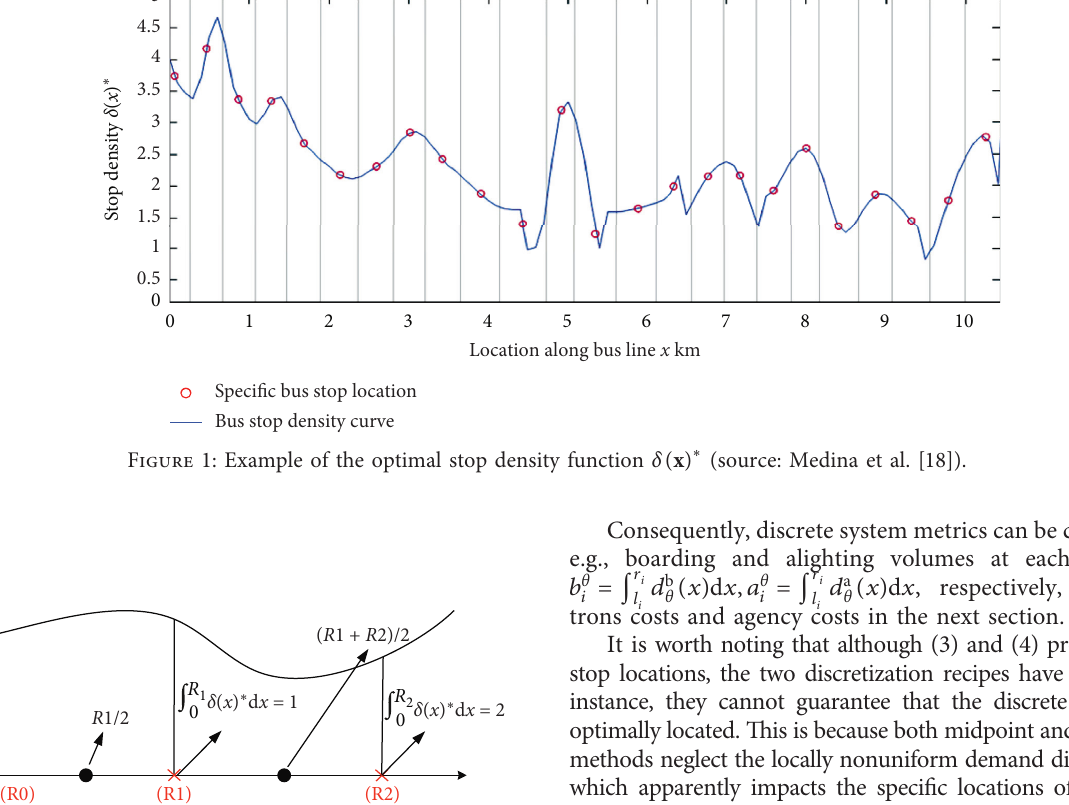
Stop location by using midpoint approach Figure 2: Illustration of two discretization